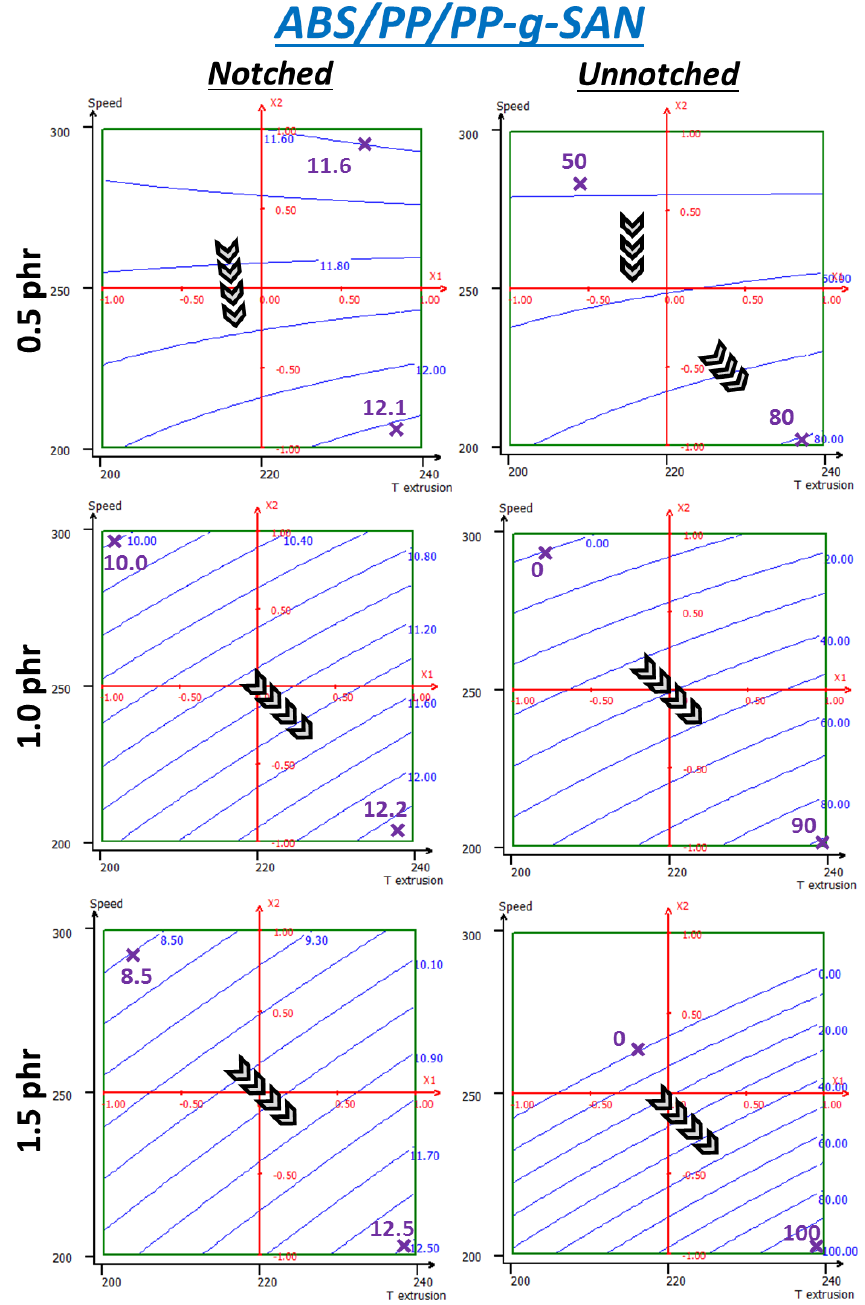
Figure 16. RSM applied to unnotched Charpy break energies (kJ/m 2 ) of ABS + 4wt% PP + PP-g- SAN—same variables as those used